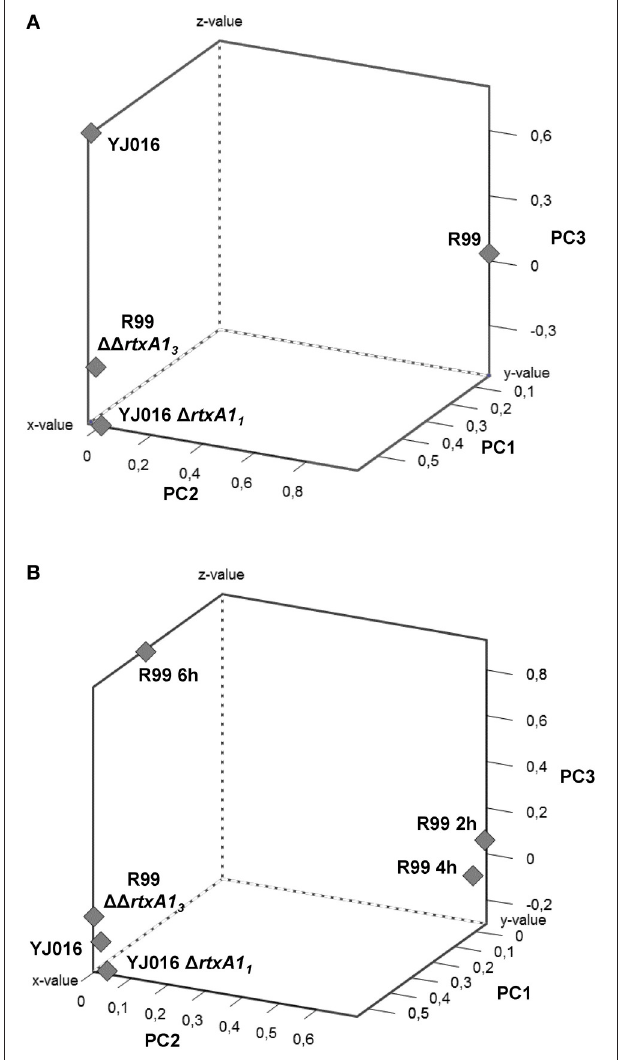
FIGURE 8 | Principal Component Analysis (PCA) 3-D plot of the gene expression. Three principal components are represented, PC1 on X-axis, PC2 on Y-axis, and PC3 on Z-axis. (A) shows the analysis of mice infected for 4 h with the wild-type strains and their derivative RtxA1 mutants. In (B) mice infected with the Bt2-SerE R99 strain for 2 and 6 h were included in the analysis.